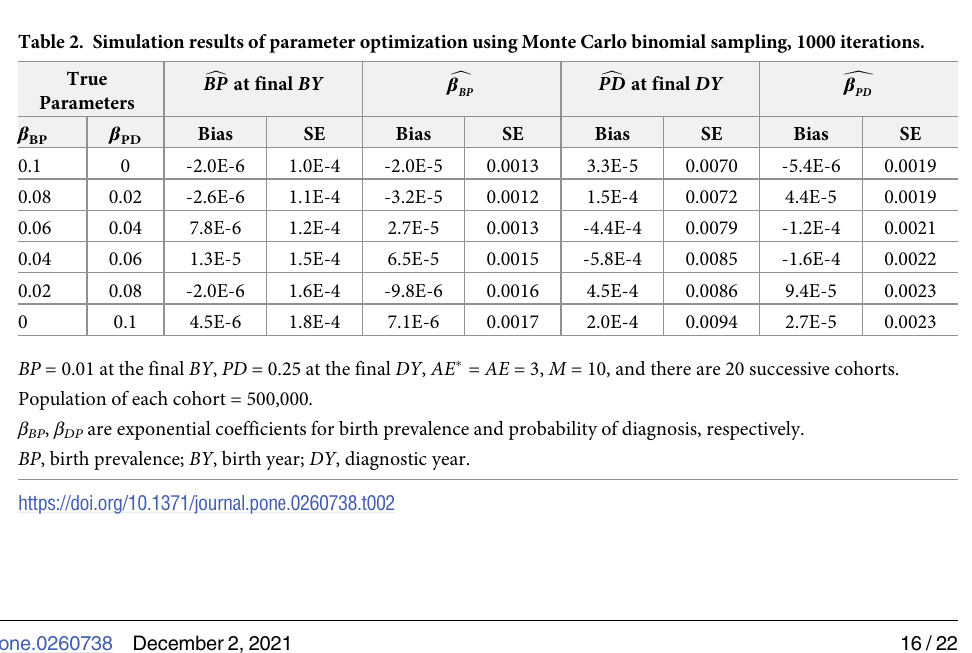
BP = 0.01 at the final BY , PD = 0.25 at the final DY , AE � = AE = 3, M = 10, and there are 20 successive cohorts. β BP , β BD are exponential coefficients for birth prevalence and probability of diagnosis, respectively.